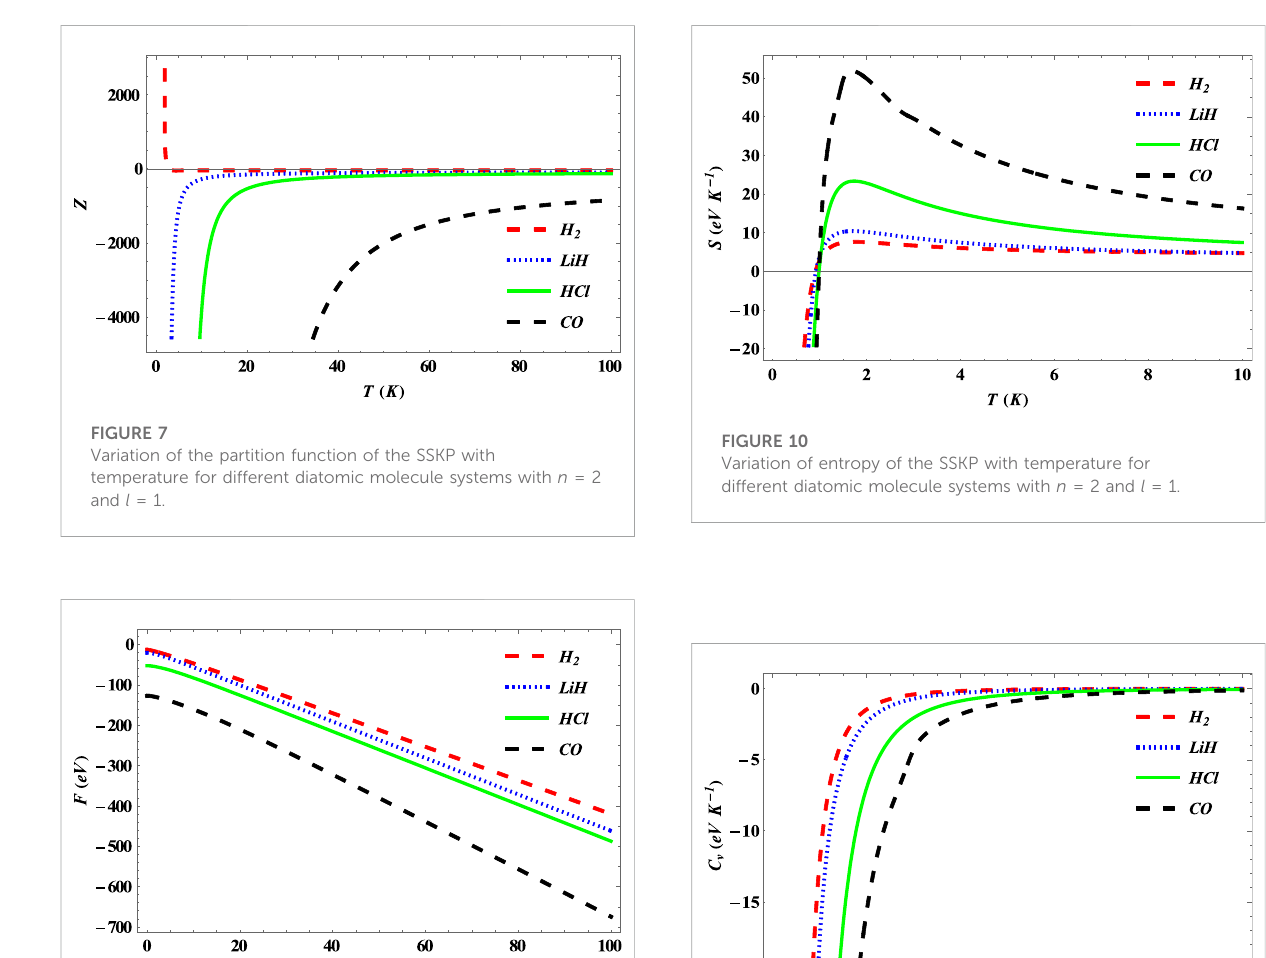
FIGURE 8 Variation of free energy of the SSKP with temperature for different diatomic molecule systems with n = 2 and l = 1.